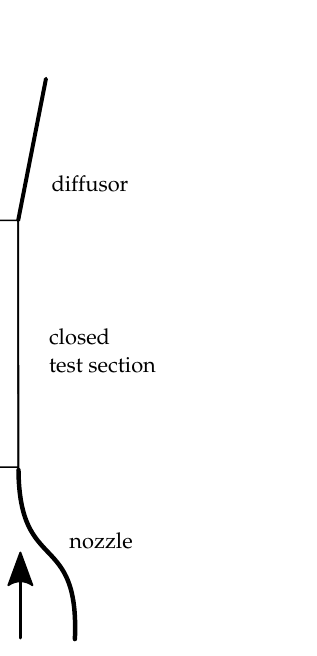
Figure 3. Schematic overview of the measurement setup in the closed test section of the Deutsche Version July 22, 2021 submitted to Appl. Sci. WindGuard’s aeroacoustic wind tunnel in Bremerhaven, Germany, adapted from [20].